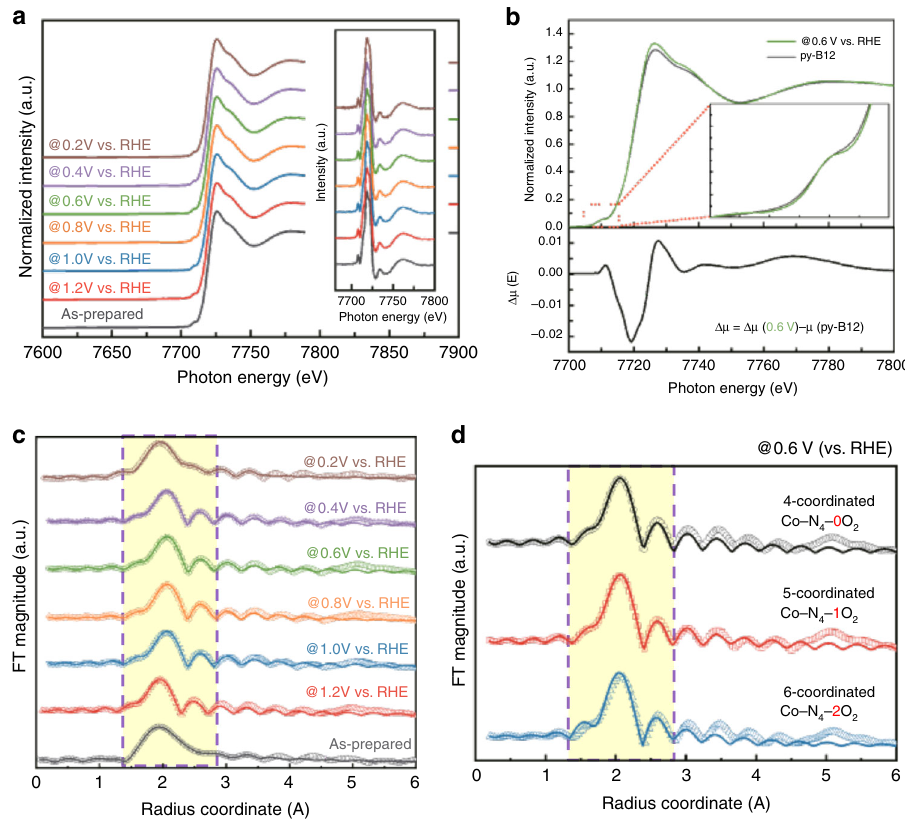
Fig. 2 In situ Co K-edge X-ray absorption. a Co K-edge XANES spectra of py-B12 at various operando biases (insert shows the fi rst-derivative spectrum). b The XANES and Δμ -XANES spectra obtained the sample at a bias of 0.6 V (vs. RHE) and in the as-prepared state. c The phase-corrected Fourier transforms EXAFS (k 3 -weighted) obtained at various operando biases. d The EXAFS spectrum, which was obtained under a bias of 0.6 V (vs. RHE), is fi tted with three different models. The region highlighted in soybean color was the fi tting region. All the signals were collected on a home-built spectroelectrochemical cell with catalyst loading of 100 mg cm − 2 and under O 2 -saturated 0.1-M HClO 4